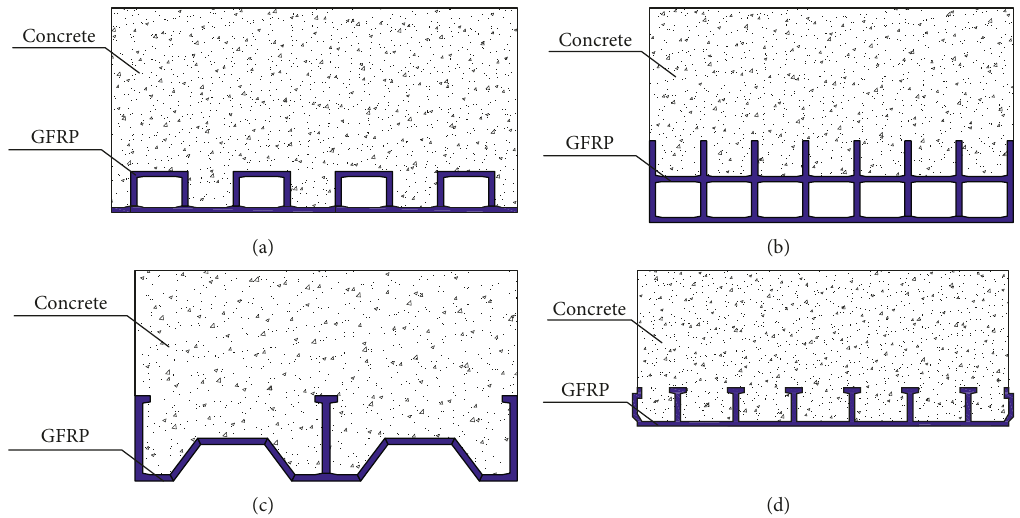
Figure 2: GFRP-concrete composite decks with different sections: (a) Type I; (b) Type II; (c) Type III; (d) Type